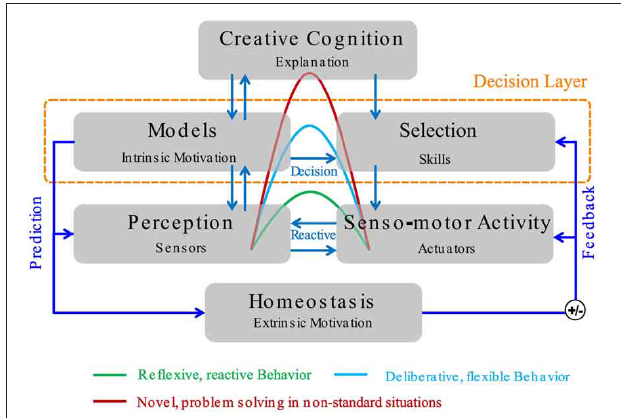
FIGURE 1 | A 3-layer control architecture, which allows the integration of reflexive reactive behaviors, more flexible decision-based behaviors, and explanation-based approaches for novel situations. Extrinsic motivation is provided by homeostatic need regulation and prediction of fitness-enhancing events. We refer to Köhler et al. (2012) for more